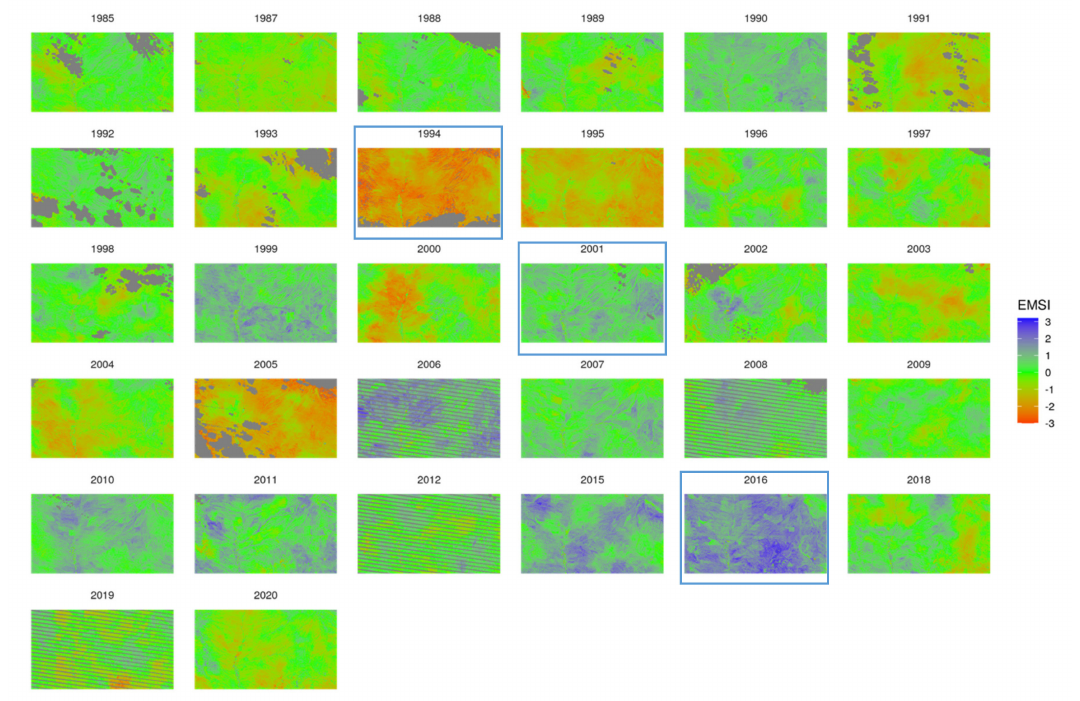
Figure A5. EMSI for 1985-2020 for Landsat 5, 7, and 8 time series for the month of August over the Arizona (US) Mexico Border region. The years 2013, 2014, and 2017 had no clear sky scenes. The years 1985, 1987, and 2001 were average years. The years 1994, 1995, and 2005 were far below average. The three years with blue highlighted boxes are shown below in more detail in Figure 11. Pixels with no data due to masking are gray.